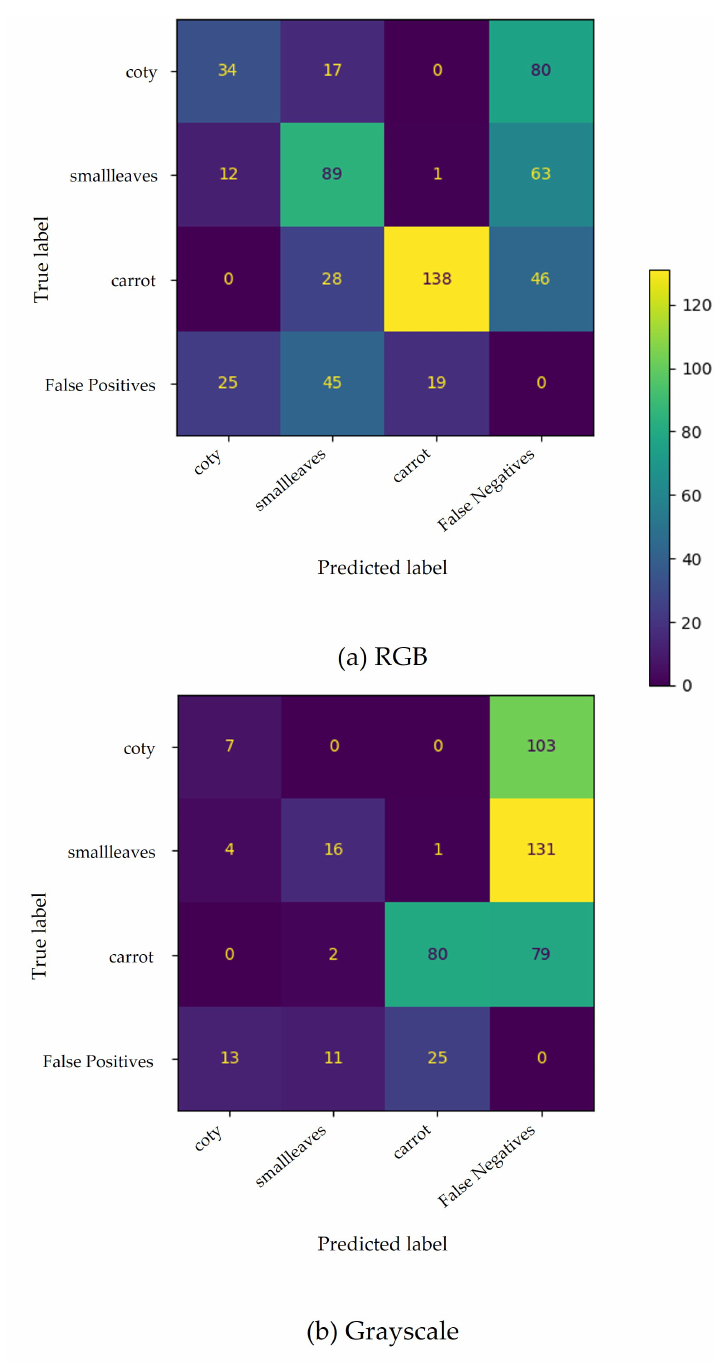
Figure 5. Confusion matrix for carrots’ phenophases based on SSD MobileNet v2 (300 × 300 px) trained with RGB ( a ) and greyscale ( b ) images. False positives and false negatives include improperly predicted plants and undetected plants,